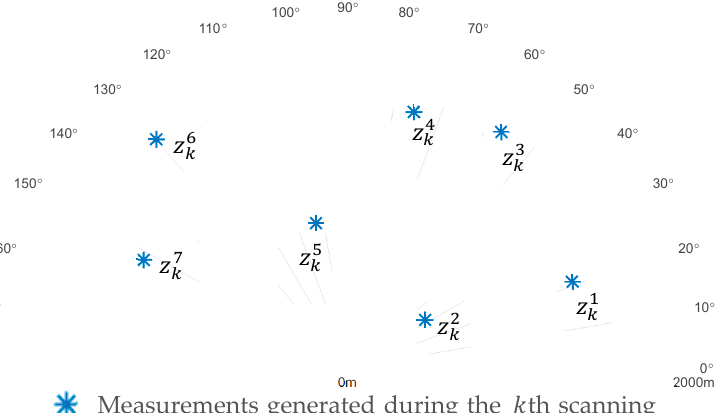
Measurements generated during the 𝑘 th scanning Figure 3. Radar measurements generated in the 𝑘 th scanning cycle and sector division according to the sampling time. d Figure 3. Radar measurements generated in the k th scanning cycle and sector division according to Figure 3. Radar measurements generated in the 𝑘 th scanning cycle and sector division according to the sampling time. the sampling